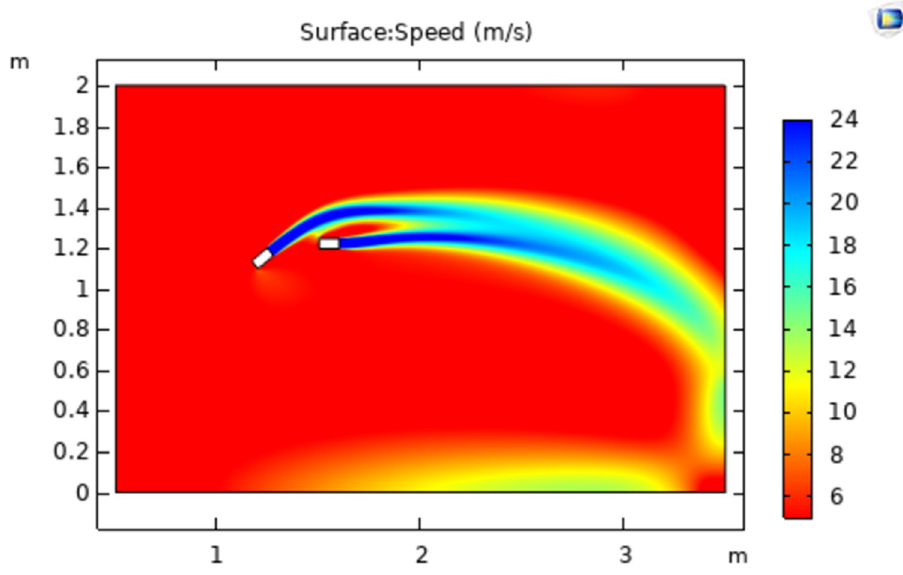
Fig 5. Flow velocity distribution from nozzles 1 and